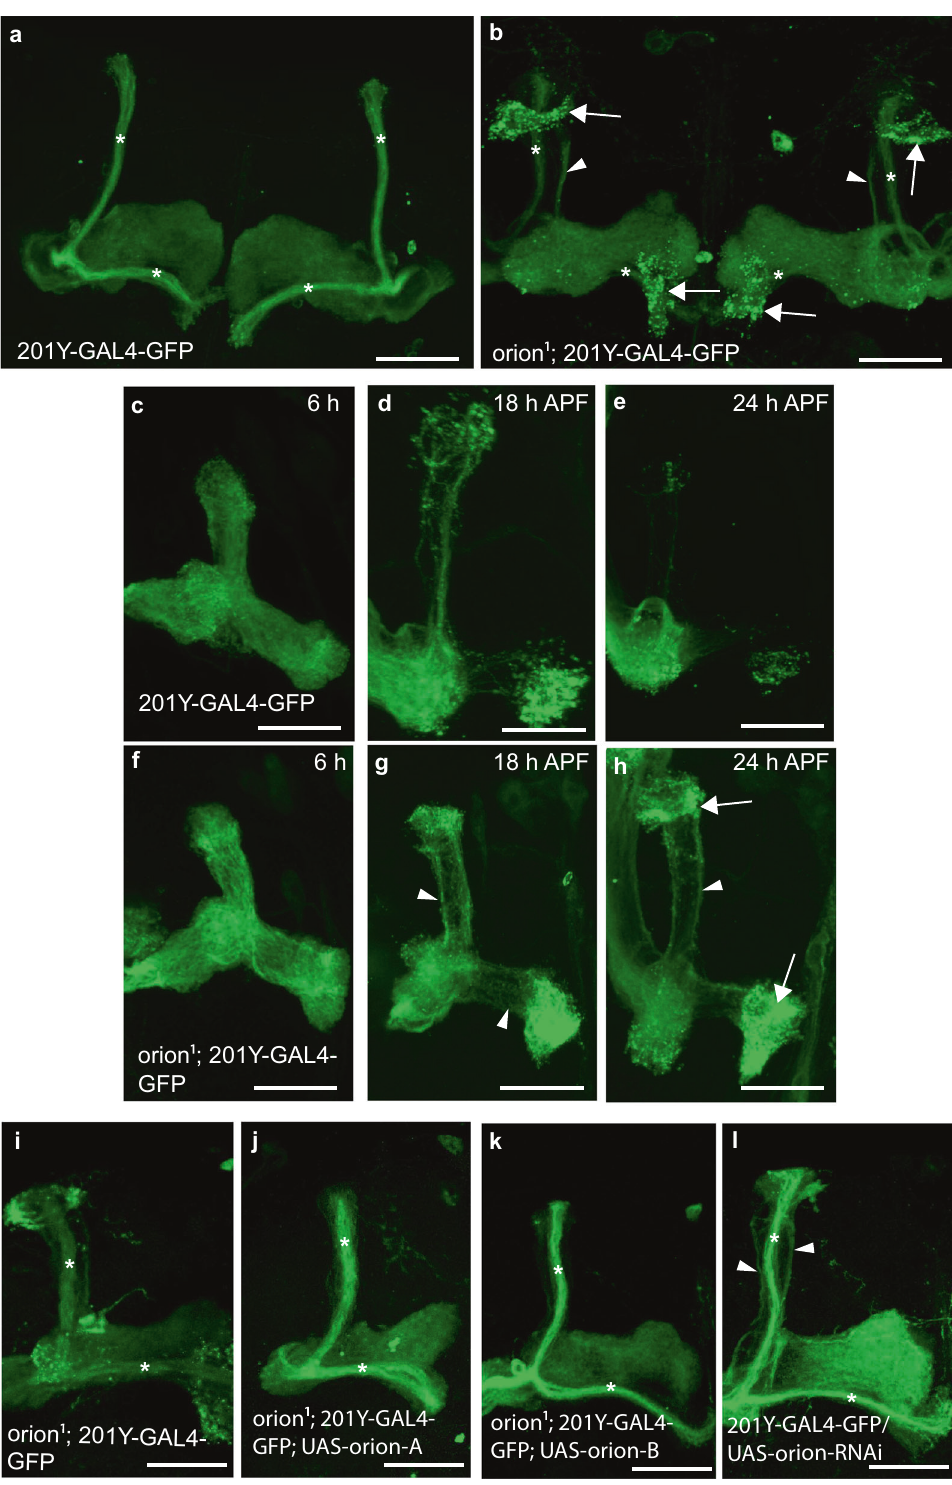
Fig. 1 The orion gene is necessary for MB remodeling. a – l γ neurons are visualized by the expression of 201Y-GAL4 -driven UAS-mCD8-GFP (green). In adults, this GAL4 line also labels the αβ -core axons shown here by asterisks. a , b Adult γ axons in control ( a ) and orion 1 ( b ). Note the presence of unpruned γ axon bundles (arrowhead) and the high amount of uncleared axonal debris (arrows) in orion 1 compared to wild-type. (n ≥ 100 MBs for control and orion 1 . See quantitation in Table 1 and Supplementary Fig. 2.) c – h γ axon development in wild-type ( c – e ) and orion 1 ( f – h ) at 6, 18, and 24 h APF as indicated. Unpruned axons (arrowhead) in orion 1 are already apparent at 18 h APF (compare g with d ) although no differences are detected at 6 h APF ( c , f ). Note the presence of unpruned γ axons (arrowhead) and debris (arrow) in orion 1 at 24 h APF ( n = 40 MBs for each developmental stage). i – k The adult orion 1 phenotype ( i ) is completely rescued by expression in MBs of UAS-orion-A ( n = 89 MBs) ( j ) or UAS-orion-B ( n = 387 MBs) ( k ). l UAS-orion-RNAi expression in MBs results in unpruned γ axon phenotypes (arrowheads) ( n = 20 MBs). Scale bars represent 40 µ m. All the images are composite confocal images. Genotypes are listed in the Supplementary list of fl y